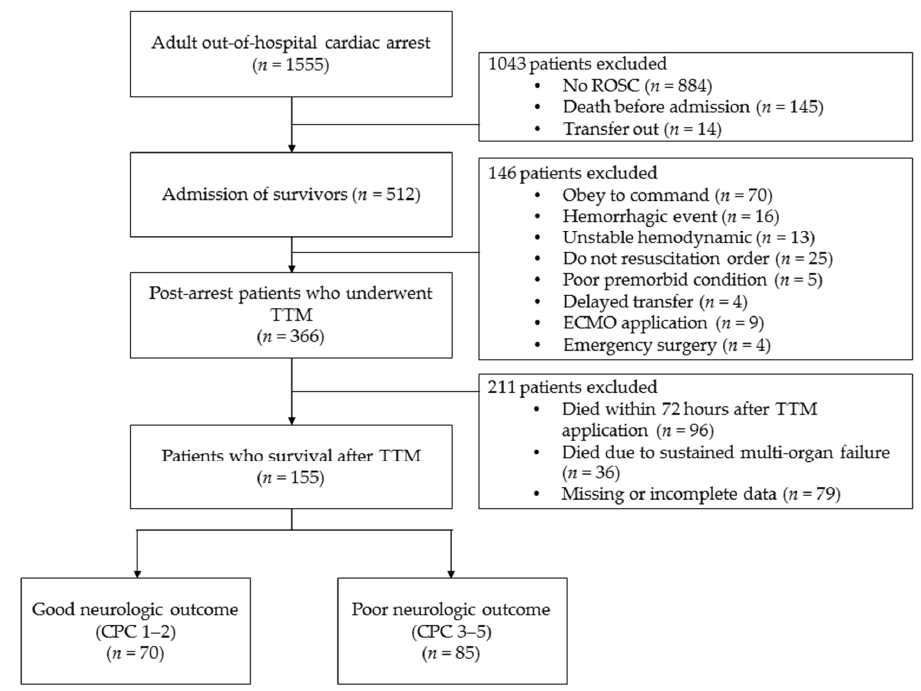
Figure 1. Study flowchart.